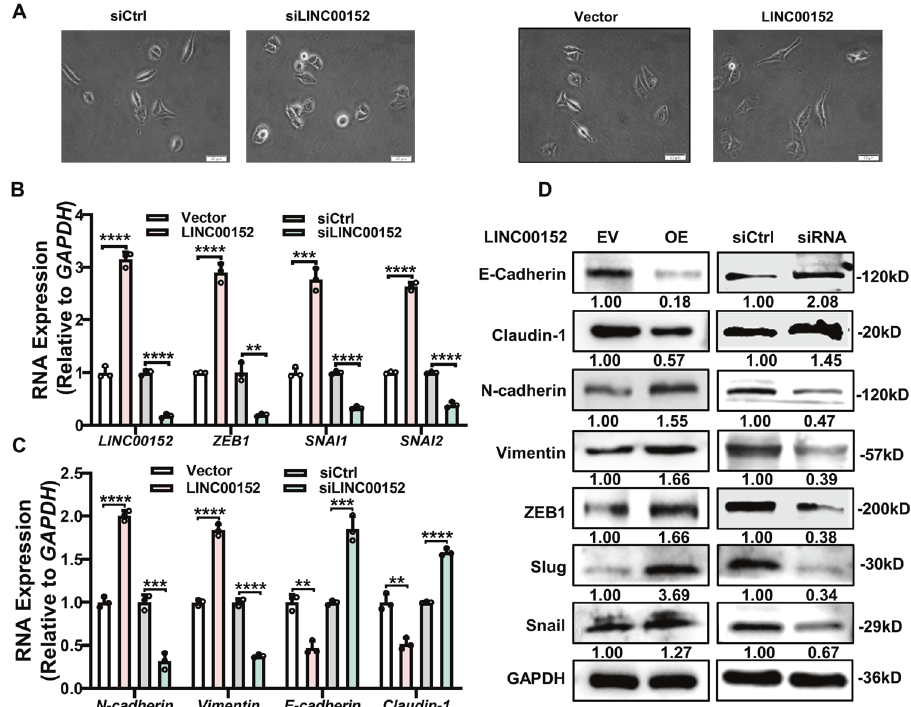
Fig. 6 LINC00152 promotes EMT of LUAD cells. A Phase-contrast microscopy images of A549 cells knockdown or overexpressing LINC00152. B – D RT-qPCR and Western blot analysis of the EMT associated genes (E-cadherin, N-cadherin, Vimentin, Claudin-1, SNAI1, SNAI2 and ZEB1) expression under which LINC00152 was silenced in Calu3 cells or overexpressed in A549 cells. Data have been presented as the mean ± SD of three independent experiments (** p < 0.01; *** p < 0.001; **** p < 0.0001. Student ’ s t